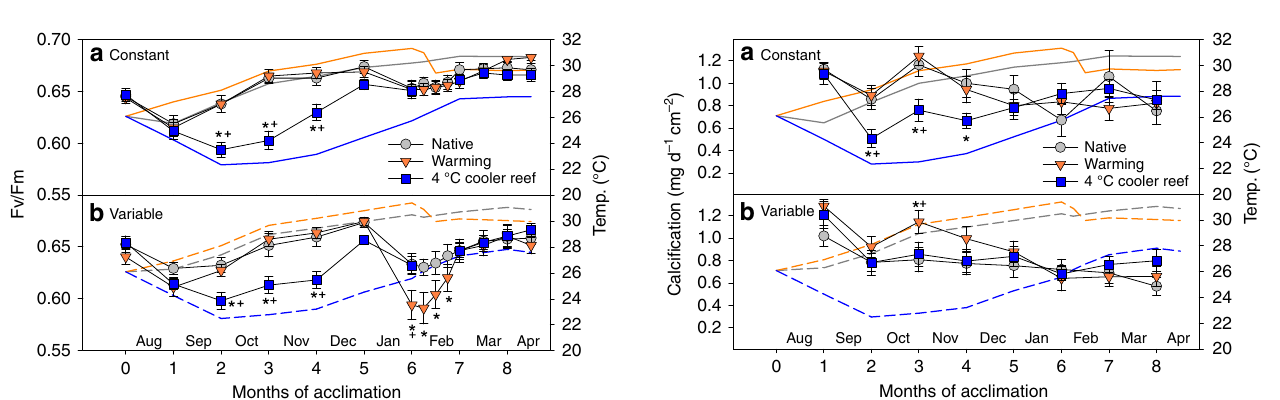
Fig. 3 Calci fi cation rate during the acclimation phase. Acropora aspera corals were maintained under a constant daily temperatures or b 4 °C daily temperature variability. Solid and dashed lines represent monthly tank temperatures for each treatment (Table S2). Mean ± 1 S.E.M. is shown. Asterisks indicate a signi fi cant difference from the native (control) treatment, whereas plus ( + ) indicates a signi fi cant difference between the warming and 4 °C cooler reef treatments ( p < 0.05; Tukey post hoc